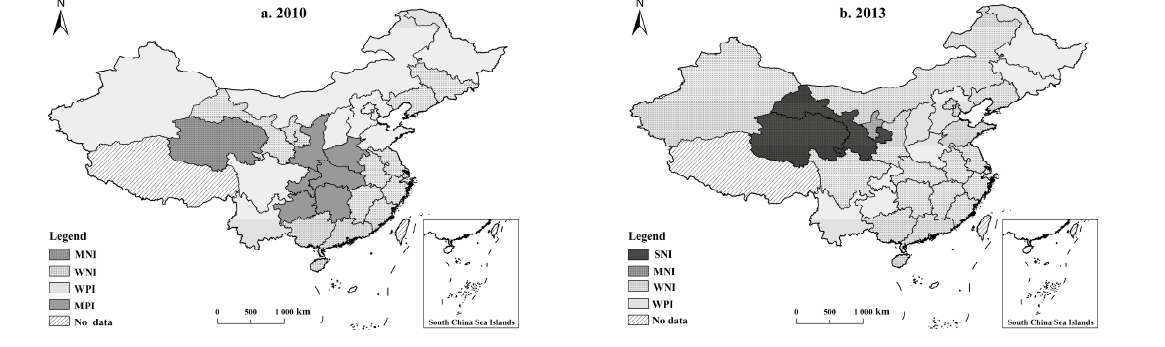
Figure 6. Spatial distribution of the regression coefficients of GDP per capita: ( a ) Spatial distribution of the regression coefficients of GDP per capita in 2010; ( b ) Spatial distribution of the regression coefficients of GDP per capita in 2013; ( c ) Spatial distribution of the regression coefficients of GDP per capita in 2016; ( d ) Spatial distribution of the regression coefficients of GDP per capita in 2019. 5. Spatial and temporal variation in the effect of the green building index on carbon emissions The maximum value of the regression coefficient of the green building index is 0.832 and the minimum value is − 0.098. As shown in Figure 7, in 2010, all 30 provinces have a positive effect. In 2013, the WNI dominated, occupying 16 provinces. In 2016, WPI occu- pied 17 provinces. In 2019, WPI occupies 21 provinces. In 2010, the green building index has a positive effect on carbon emissions from public buildings in all regions. However, by 2019, the inhibitory effect has 9 provinces. According to previous studies, green build- ings contribute to carbon emission reduction than non-green buildings, but this study finds that the large-scale effect of carbon emission reduction from green buildings has not yet been developed.